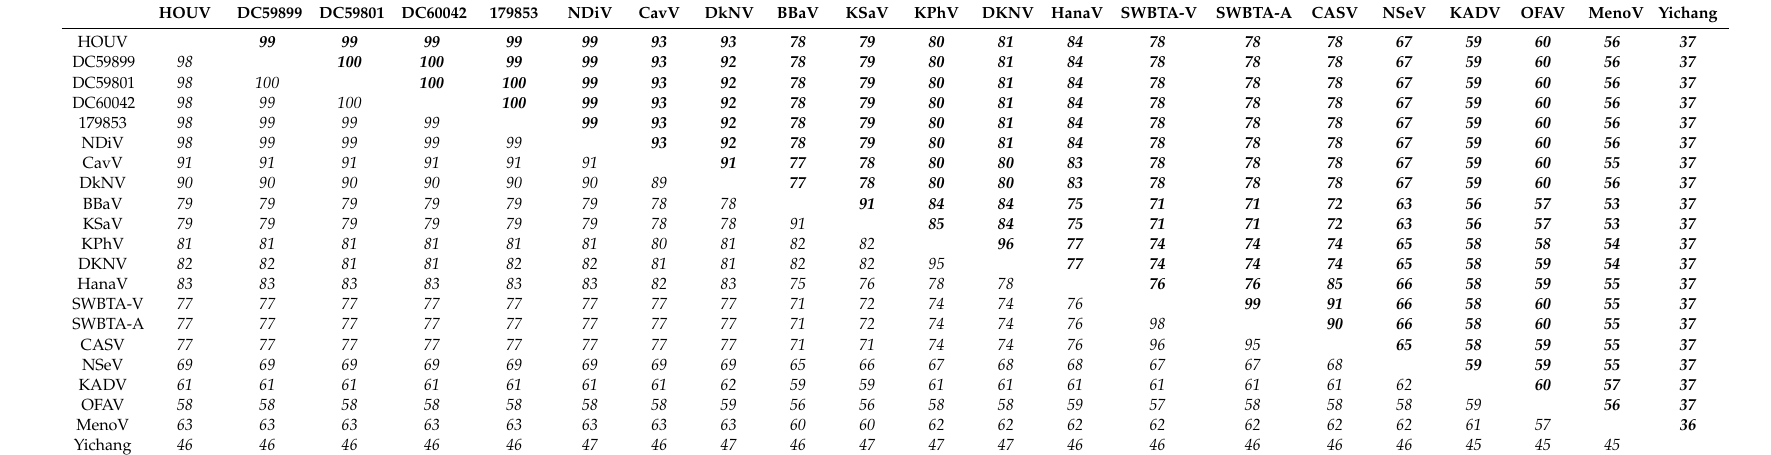
Table 2. Nucleotide identities over full genome and amino acid identities for complete